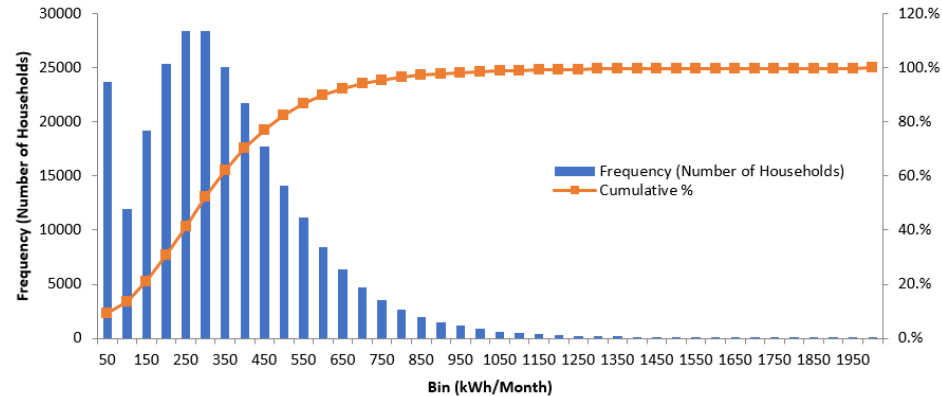
Figure 6. Cumulative % for the ordinary households in January.